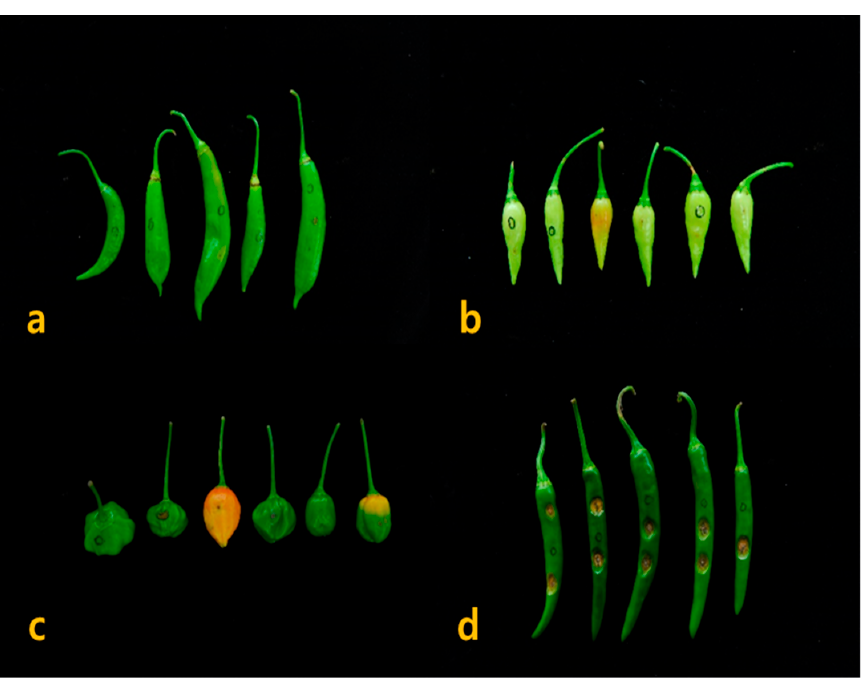
Figure 3. Anthracnose symptoms on resistant and susceptible Capsicum accessions. Resistant response of ( a ) C. baccatum and ( b ) C. chinense ; Moderate resistant response of ( c ) C. chinense and Susceptible response of ( d ) C. annuum .